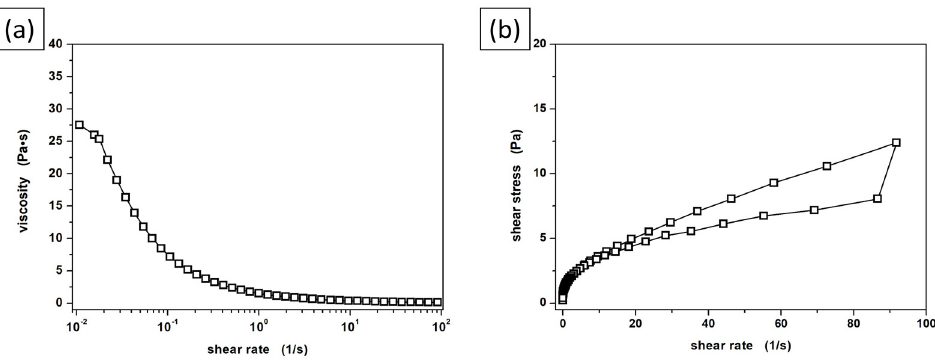
Figure 3. Sedimentation test of the slip from the Al 2 O 3 /Ti system containing 50% volume of the solid phase, including 10% volume of the metallic phase.